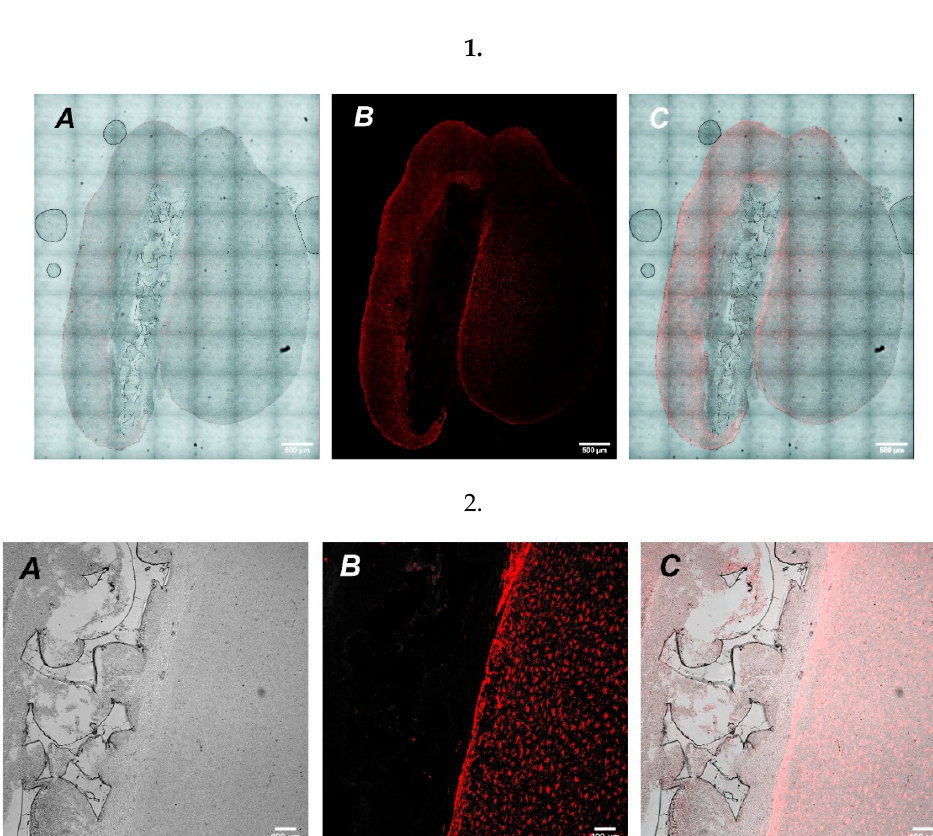
Figure 6. A series of confocal tilescans (Row 1 ) and magnified high resolution images (Row 2 ) of mice brain (frontal cut) at the 7th day after UHMWPE implantation. ( A )—UHMWPE in brain tissue, phase contrast (grey); ( B )—GFAP stained SH-SY5Y (red); ( C )—merged. Scale: Row 1—500 µm, Row 2—100 µm.